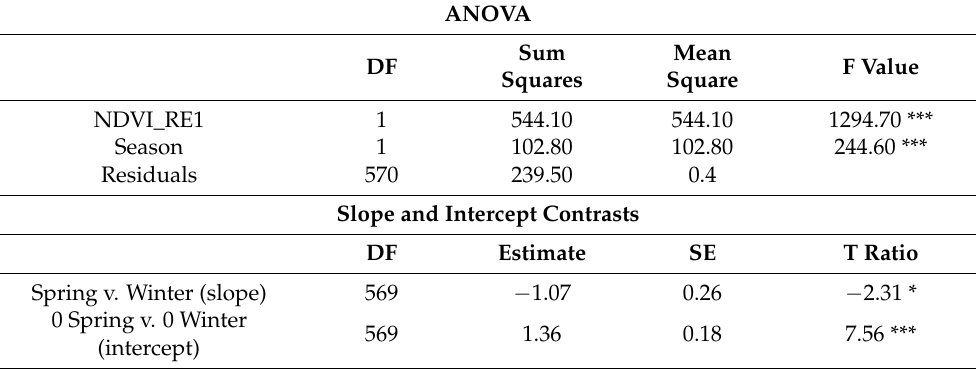
Table A1. Season